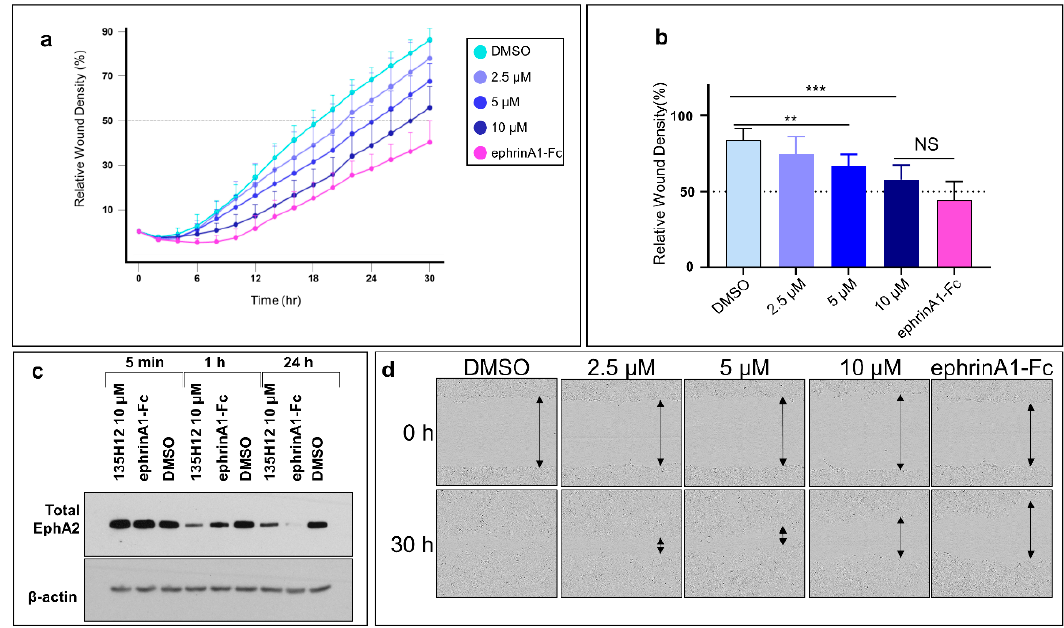
Figure 5. Pharmacological inhibition of EphA2 expression partially impairs migration of pancreatic cancer cells. ( a ) Scratched confluent WT-BxPC3 cells were treated with either 135H12 at different concentrations or 1 µ g / mL ephrinA1-Fc and were imaged every 2 h. ( b ) Histogram of relative wound density after 30 h shows significant decrease of cell migration when treated with 5 µ M and 10 µ M of 135H12 or ephrinA1-Fc. ( c ) Western blot of BxPC3 cell lysates after exposure for 5 min, 1 h or 24 h to indicated agents. ( d ) Representative images from treated wells at times 0 and 30 h. **, p < 0.005; ***, p < 0.001. Error bars represent standard deviation.